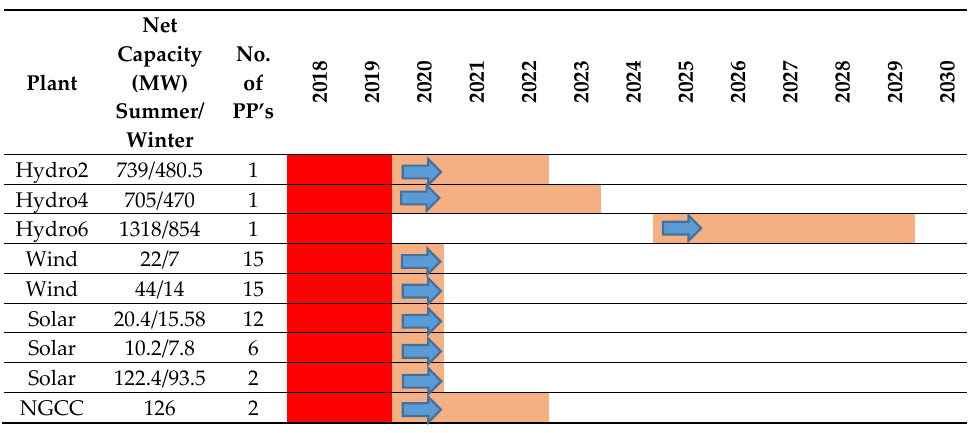
Table A4. Details of the Plants Installation under Capacity Expansion: Low GDP Fuel Balancing (4–40% Mitigation).